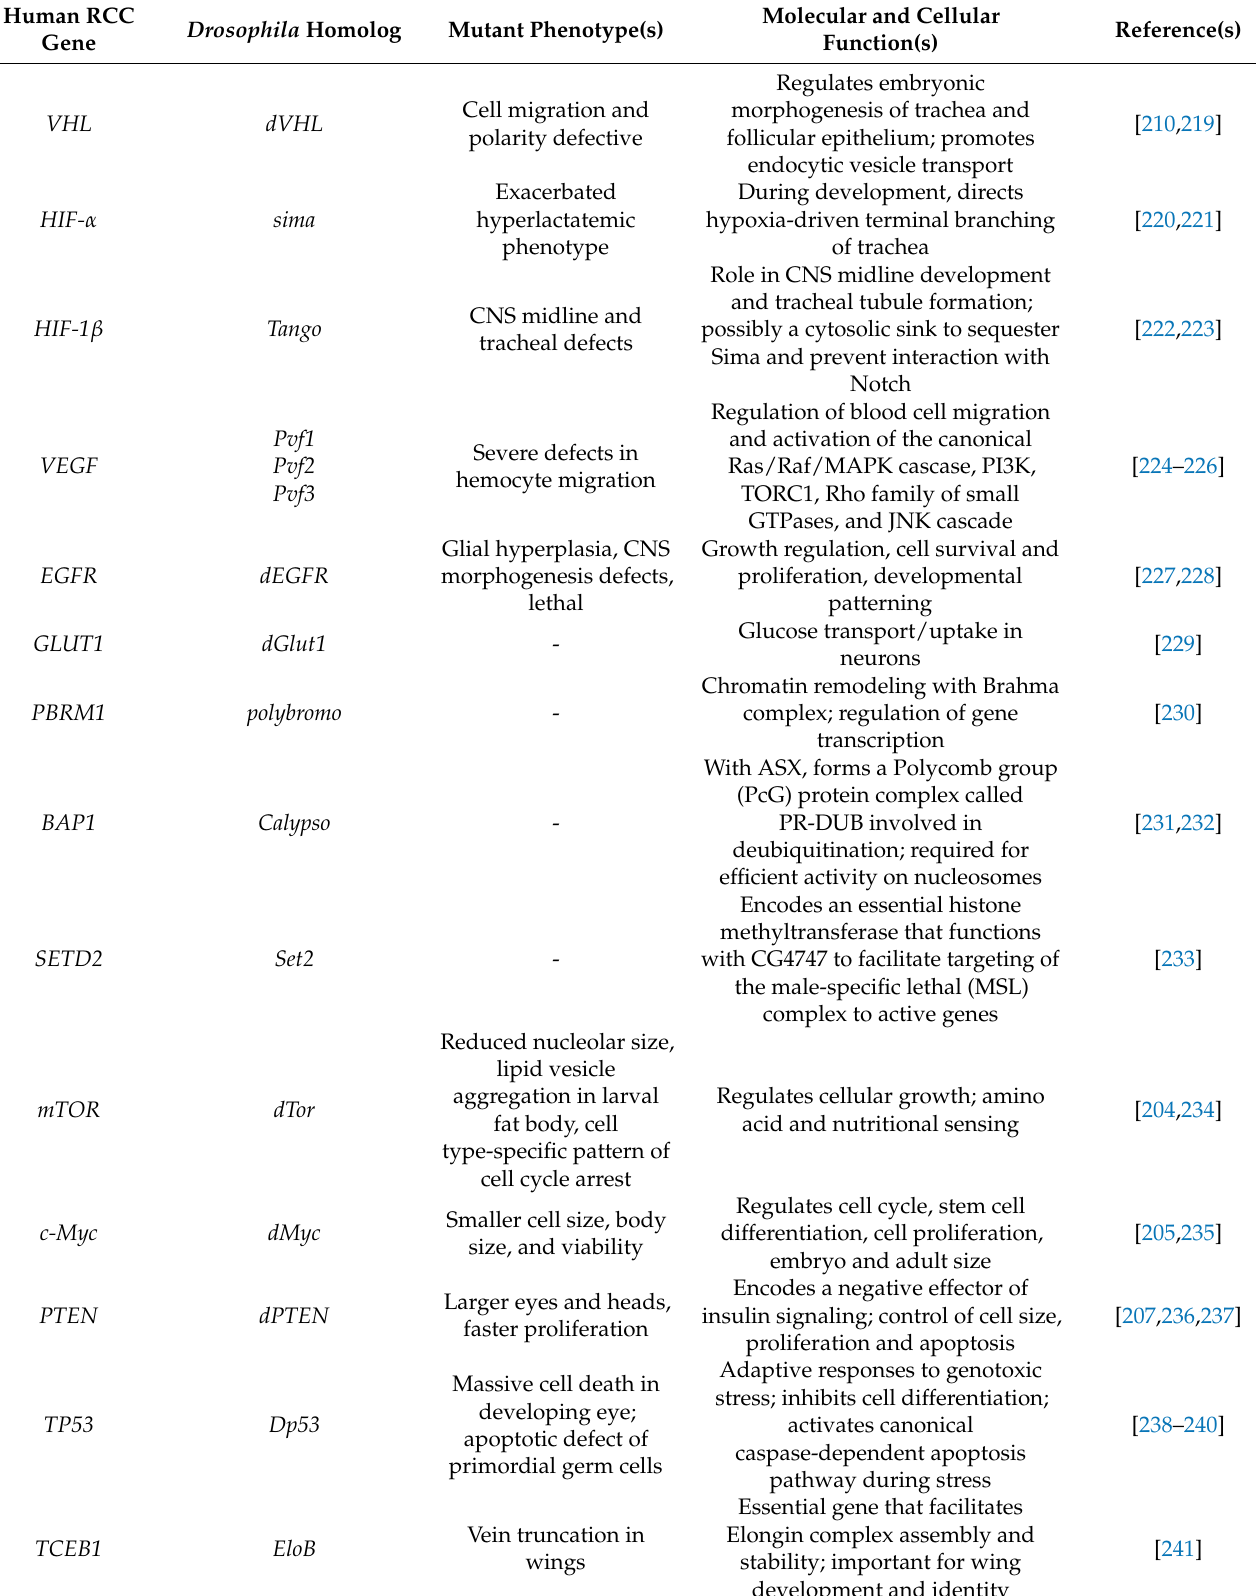
Table 4. Drosophila melanogaster RCC and PKD gene homologs and related